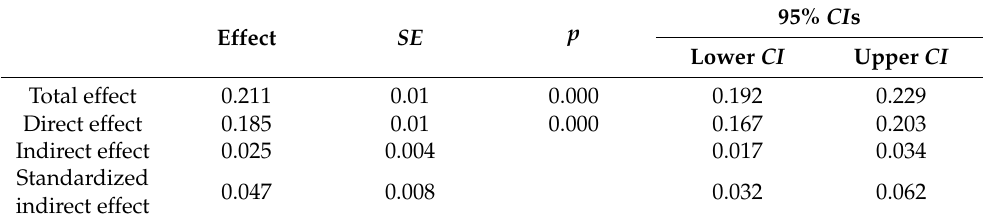
Table 9. Effects in the mediation model.